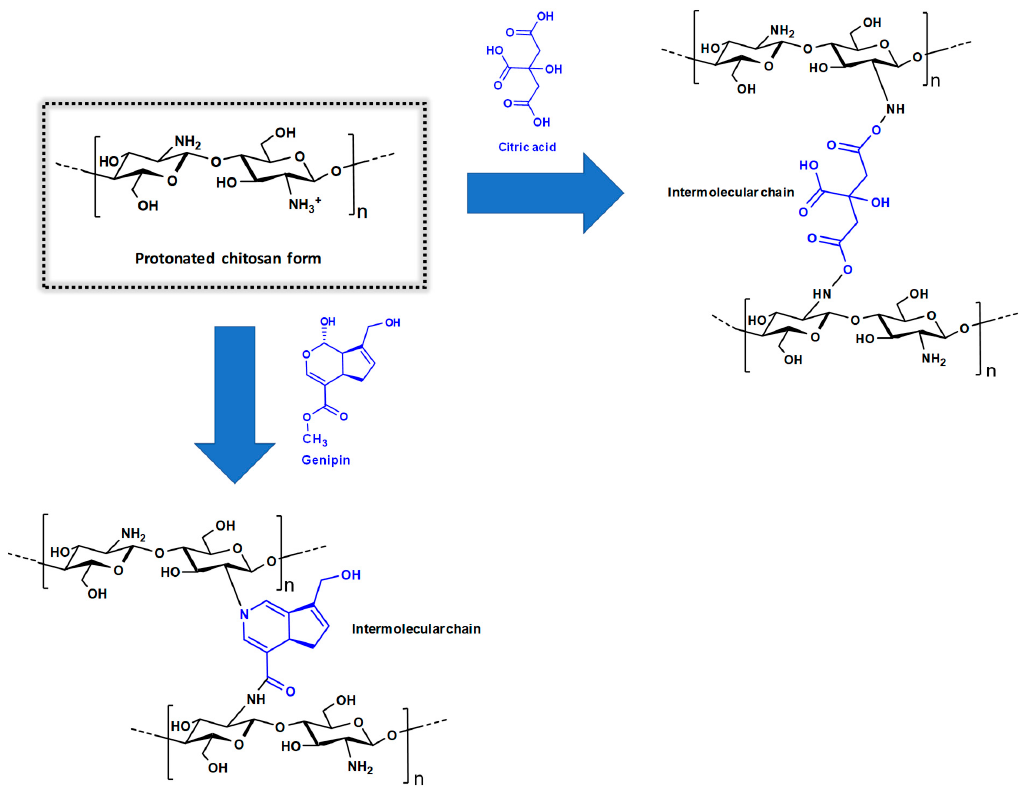
Figure 5. The mains cross-linking reactions using chitosan.